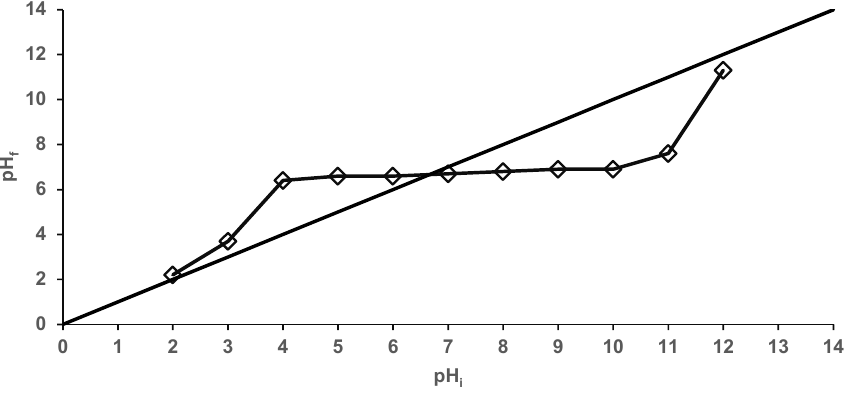
Figure 6. Biosorbent point of zero charge.